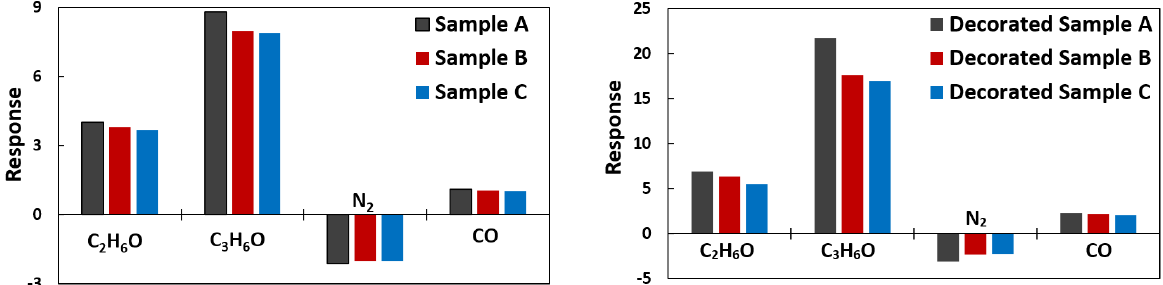
Figure 12. Selectivity measurements of the three different density samples, comparing the response toward ethanol, acetone, nitrogen, and carbon monoxide gases. In the measurements, concentration of different gases is fixed at 100 ppm at room temperature.